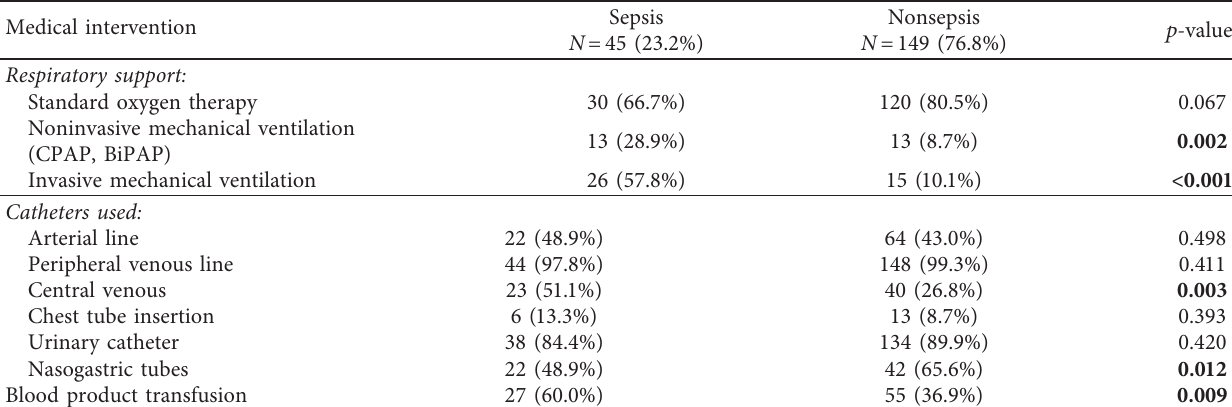
Table 5: Medical interventions used for sepsis and nonsepsis patients.